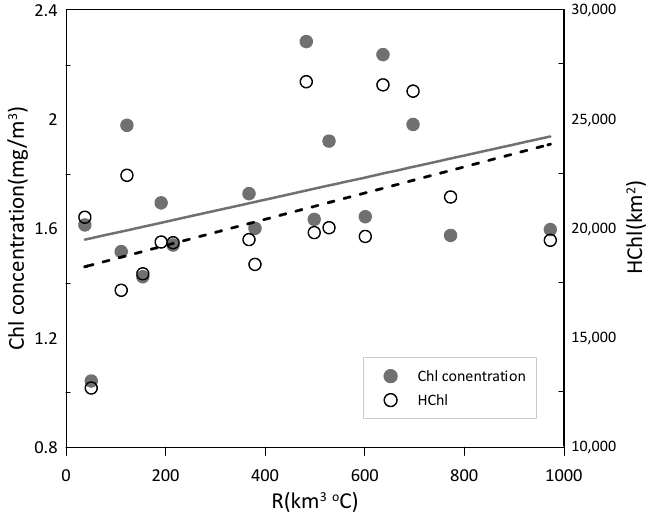
Figure 10. Relationship between upwelling intensity (R) and chlorophyll a (Chl) concentration and the area of high Chl (HChl) for the coastal upwelling system of the Taiwan Strait. The weak positive correlation between upwelling intensity (R) and Chl concentration (Figure 10) indicates that strong upwelling can enhance phytoplankton growth by increasing the nutrient supply from subsurface layers. The correlation coefficients (r) were 0.37 ( p = 0.14, n = 17) for Chl concentration and 0.47 ( p = 0.057, n = 17) for high Chl area. These results are consistent with other studies from many coastal upwelling regions, which demonstrate that the phytoplankton production can be modified by local supply of nutrients through coastal upwelling [72,73]. The weakened upwelling in the TWS after 2000 (Figure 3 and Table 1) should be not favorable for phytoplankton growth. However, because the MODIS ocean color data are only available after 2002, we cannot compare the variation in Chl concentration before and after 2000. Therefore, maintaining a long time series of consistent ocean-color products is very important for evaluating the impact of climate change on biological fields.